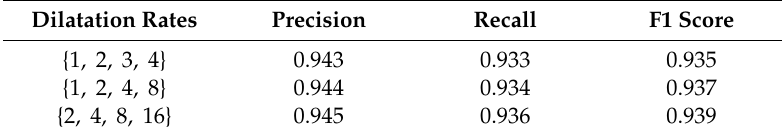
Table 2. Experimental results for di ff erent dilation rates on CFD database.